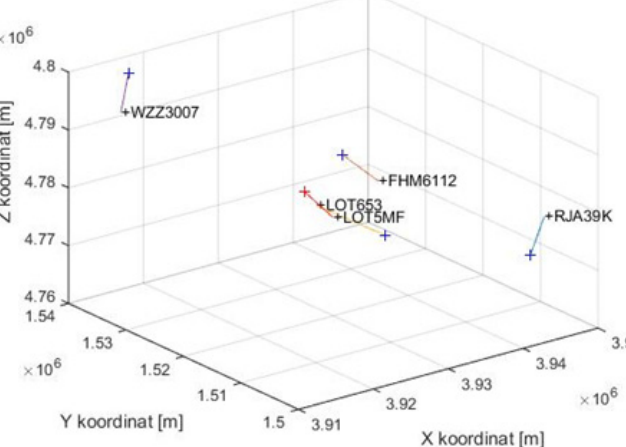
Figure 3. FOs’ flight trajectories for straight flights. Table 1. Initial coordinates of users by flightradar24.